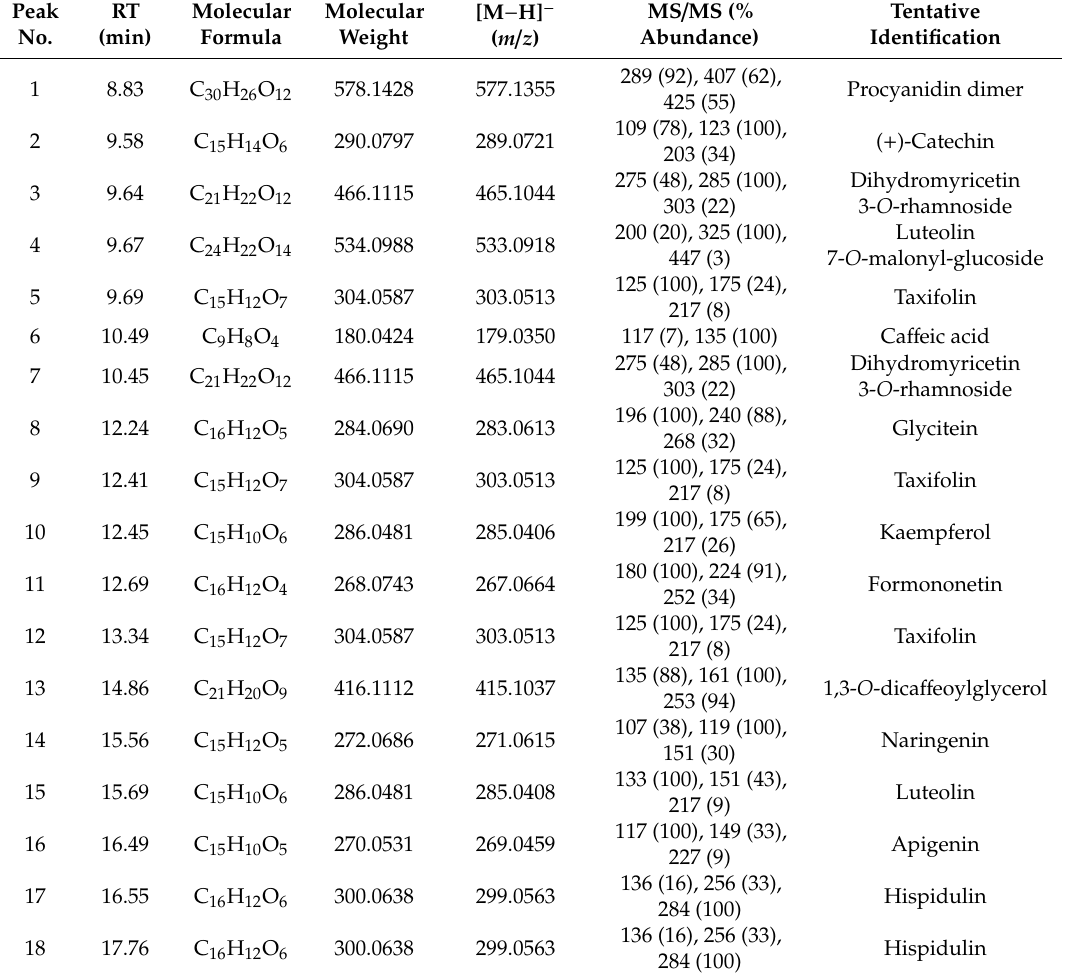
Table 4. Phenolic compounds identified in the ethanol extracts of DSOR 33 by UHPLC-Q-TOF-MS 2 . RT: Retention time.